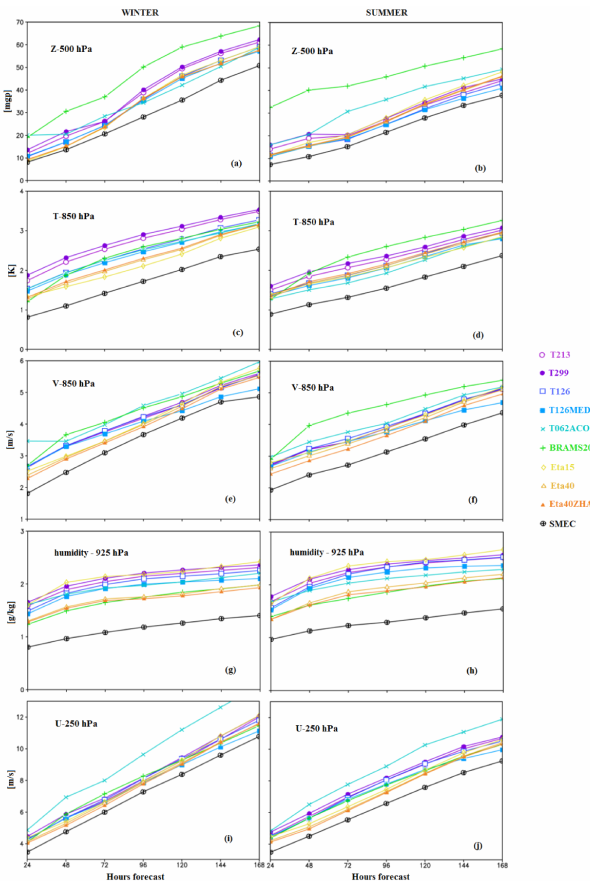
Figure 9. Time evolution of the spatial mean of the RMSE (calcu- lated from the NCEP analyses) of 500hPa geopotential height (a, b) , 850hPa air temperature (c, d) , 850hPa meridional wind (e, f) , 925hPa specific humidity (g, h) and 250hPa zonal wind (i, j) for the winter (left column) and summer (right column) trimesters.